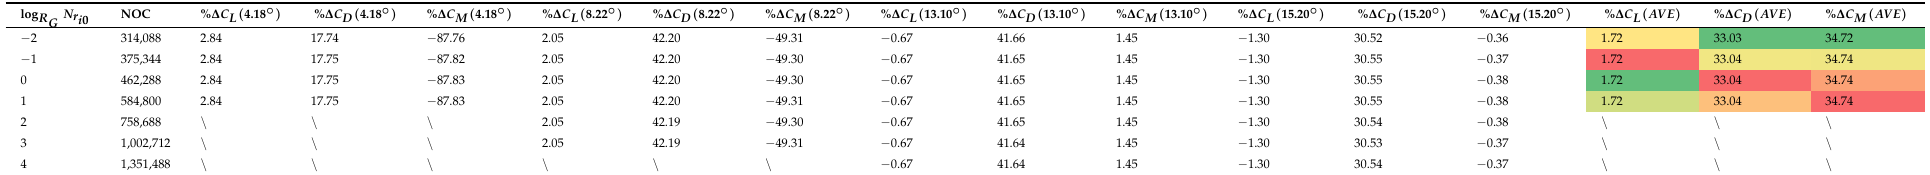
Table 18. Comparison of results of H-mesh based on various radial nodes to experimental benchmark data adopted from [25] in relative differences with 150 nodes in radial directions for reference setting.